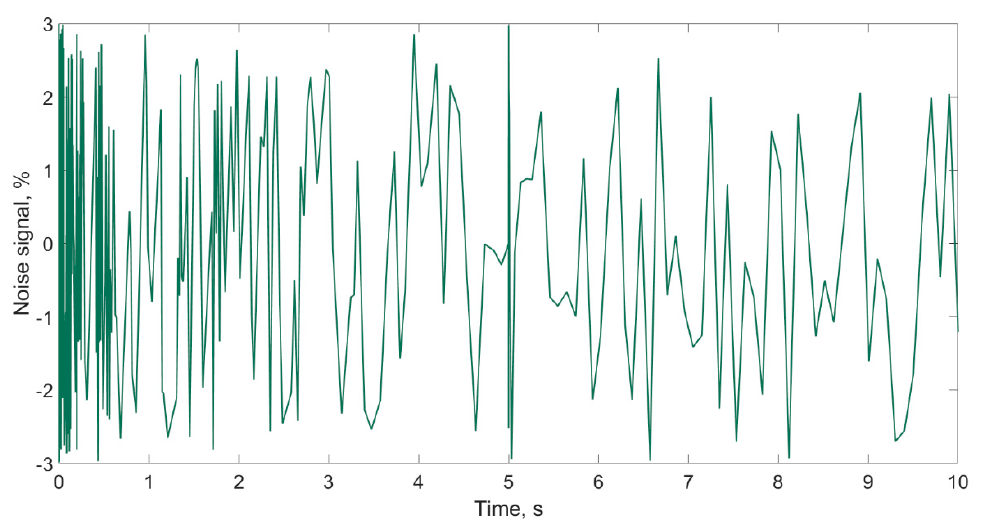
Figure 9. Noise signal with a random course at a frequency of 2 mHz and an amplitude of 3%.